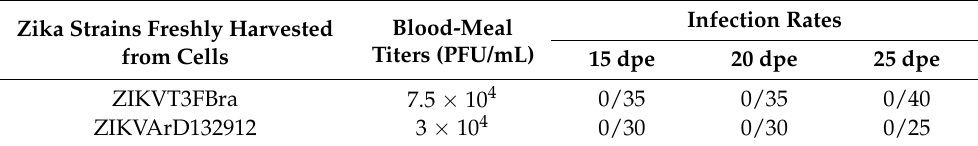
Table 3. Infection rates of C. quinquefasciatus orally exposed to ZIKV strains frozen for one week. Blood-Meal Zika Strains Frozen a Week